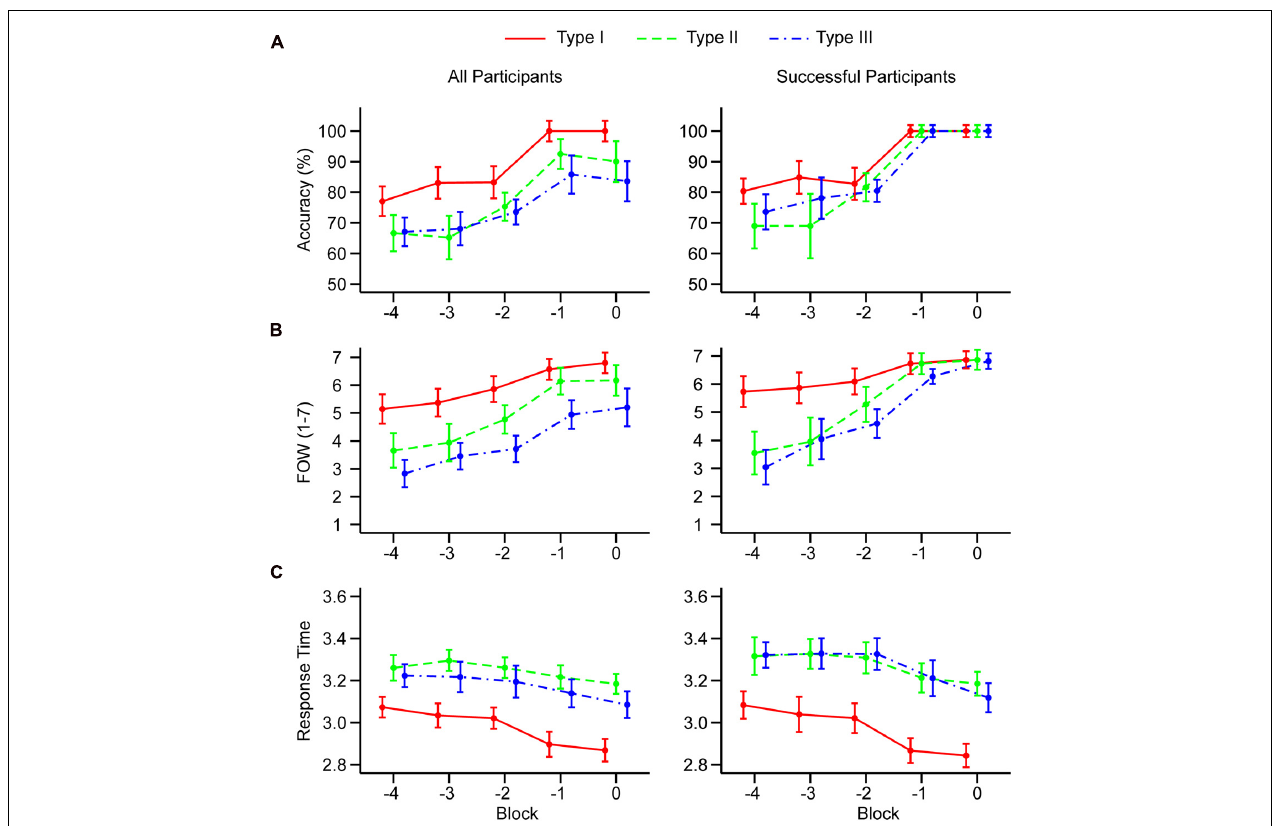
FIGURE 2 | Mean accuracy (A), feeling-of-warmth judgments (B), and log 10 transformed response times (C) in the last five learning blocks. Results are shown separately for all participants (left column) and for participants who successfully learned all three tasks (right column). Blocks are counted relative to the end of the learning session. Error bars represent 95% within-subjects confidence intervals computed following Cousineau (2005) and Morey